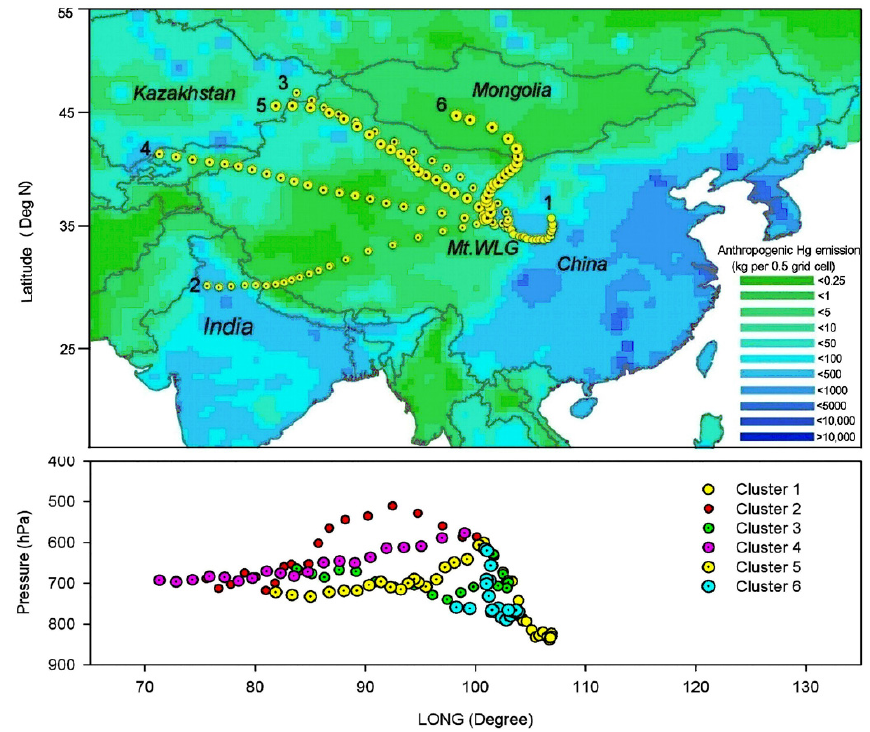
Fig. 5. Five-day mean trajectory clusters ended at WLG and the spatial distributed inventories of anthropogenic Hg emission in Asia (Pacyna et al., 2005). The circles on the clusters represent 6-h